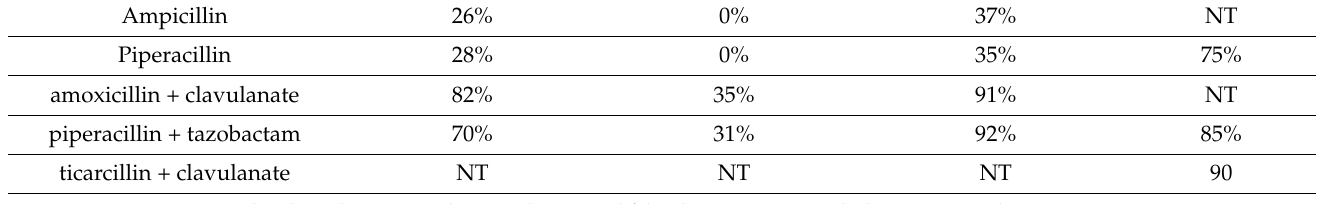
Pseudomonas Escherichia coli Klebsiella pneumoniae Proteus mirabilis aeruginosa n = 61 n = 32 ( n = 25) n = 21